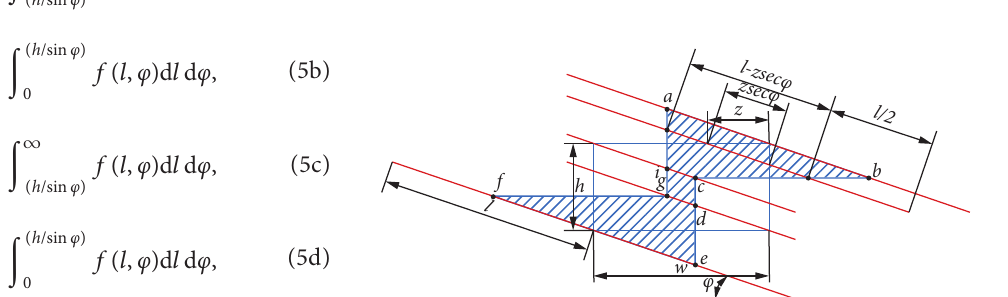
Figure 3: Discontinuities with both ends censored, l < ( h /sin φ ) and φ ≥ tan − 1 ( h / w ) .